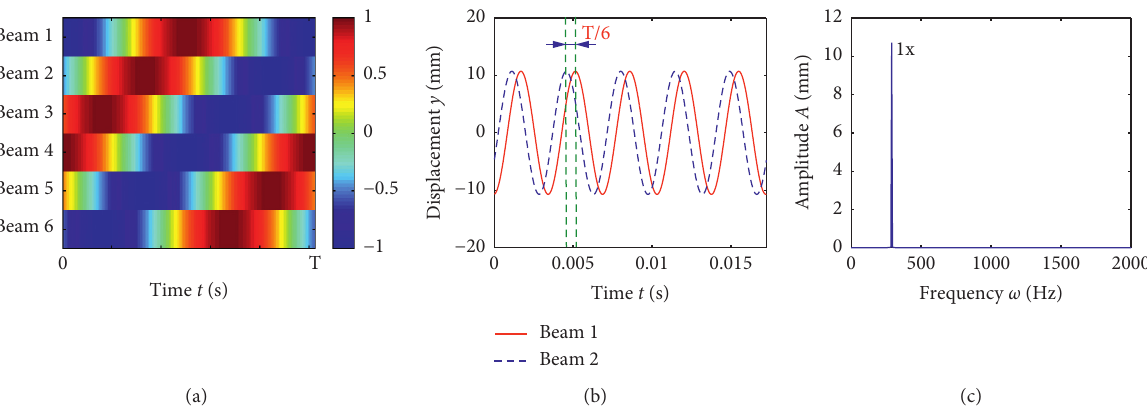
Figure 21: The response of beam tip for μ � 0.8: (a) response of beam 1 to beam 6, (b) response curve of beams 1 and 2, and (c) spectrum plot of beam